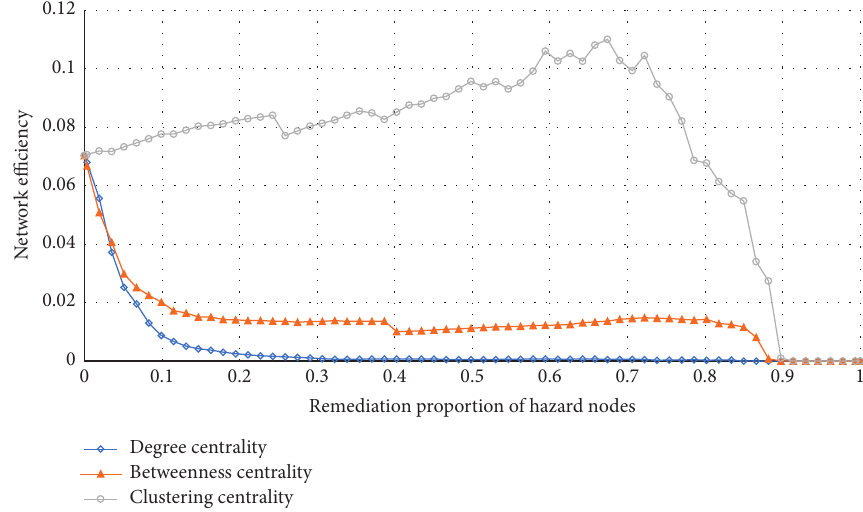
Figure 9: The change of the network efficiency of the